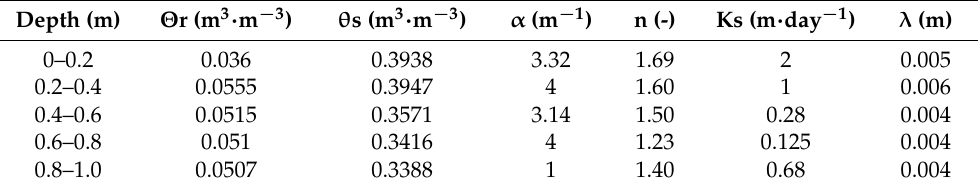
Table 4. Calibrated soil hydrodynamic and solute transport parameter